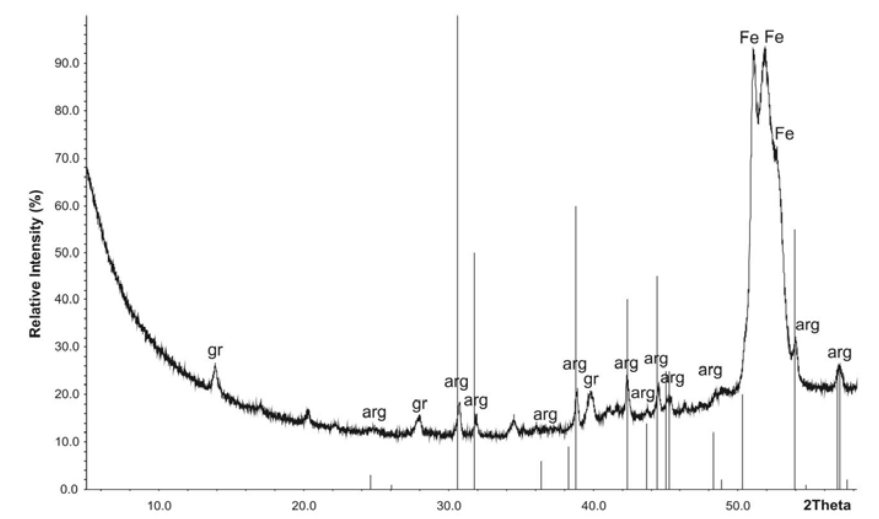
Fig. 7 X-ray diffraction pattern for sample located 5 cm from reactive zone entry. Arg indicates aragonite, gr indicates green rust-CO